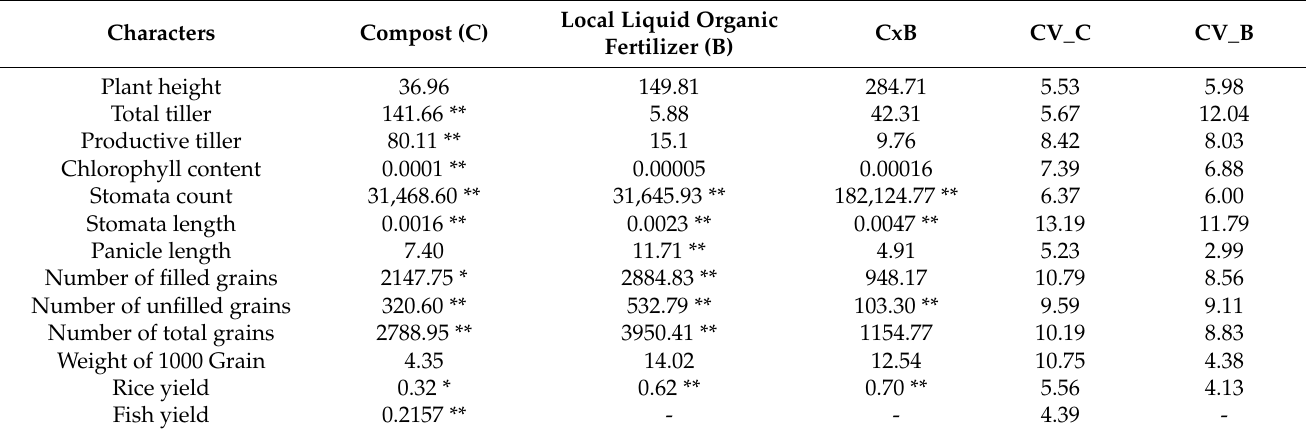
Table 5. Analysis of variance compost and local liquid organic fertilizer treatment of rice growth